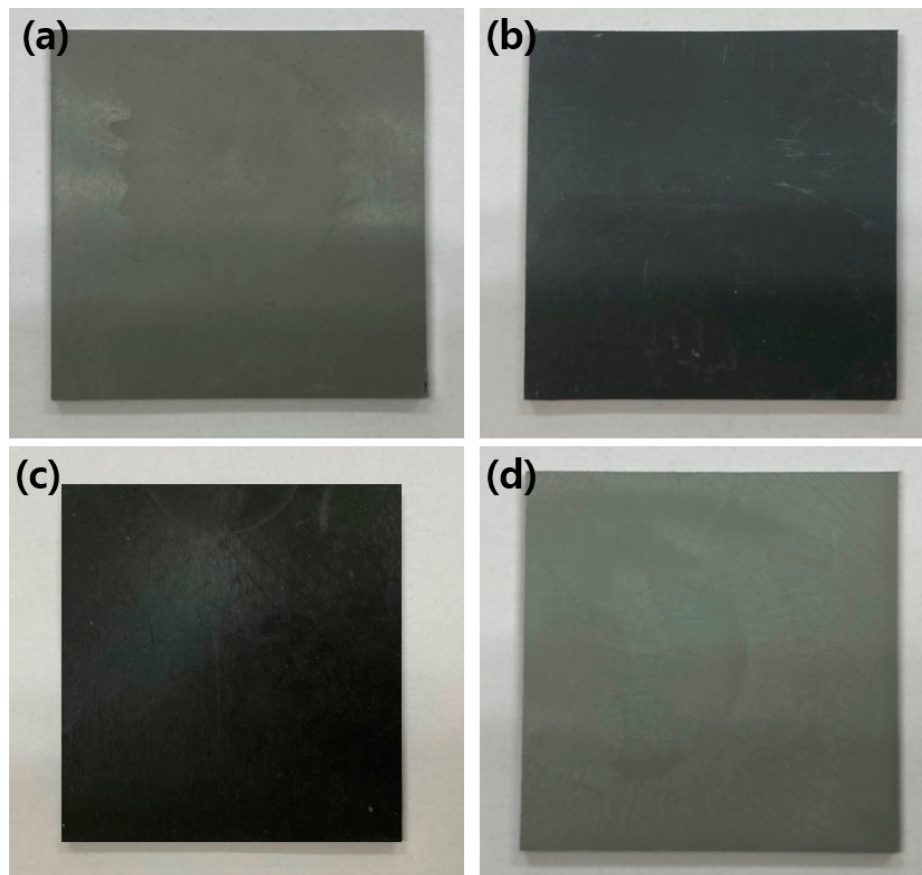
Figure 1. Mold samples through shielding material mixing composition (150 mm × 150 mm × 3 mm (150 ± 0.3 g)): ( a ) PWBa-80 (W, Ba), ( b ) PWBi-80 (W, Bi), ( c ) PW-85 (W), and ( d ) PWBaBi-80 (W, Ba, Bi).